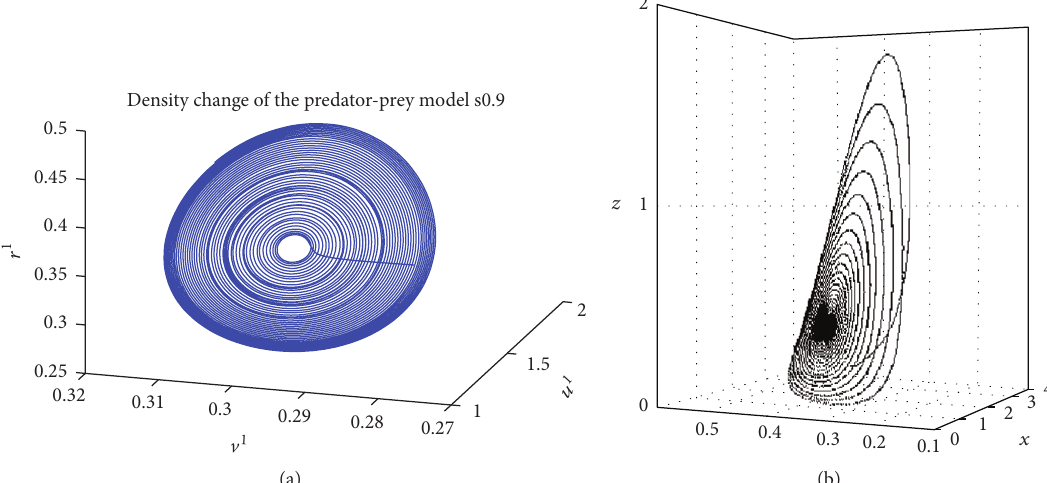
Figure 6: Here we take the parameters as mentioned earlier from [26], 𝑟 = 0.5 , 𝑚 = 1 , 𝑢 = 0.1 , 𝛾 = 1.5 , 𝑡 1 = 1.3 , 𝑠 = 0.9 . We clearly see that, at 𝑠 = 0.9 , Φ < 0 , from Figure 5, and we expect limit cycle dynamics, which we see in (a). We compare to the simulation from [26] in (b), which shows a stable spiral at 𝑠 = 0.9 , which is clearly incorrect.